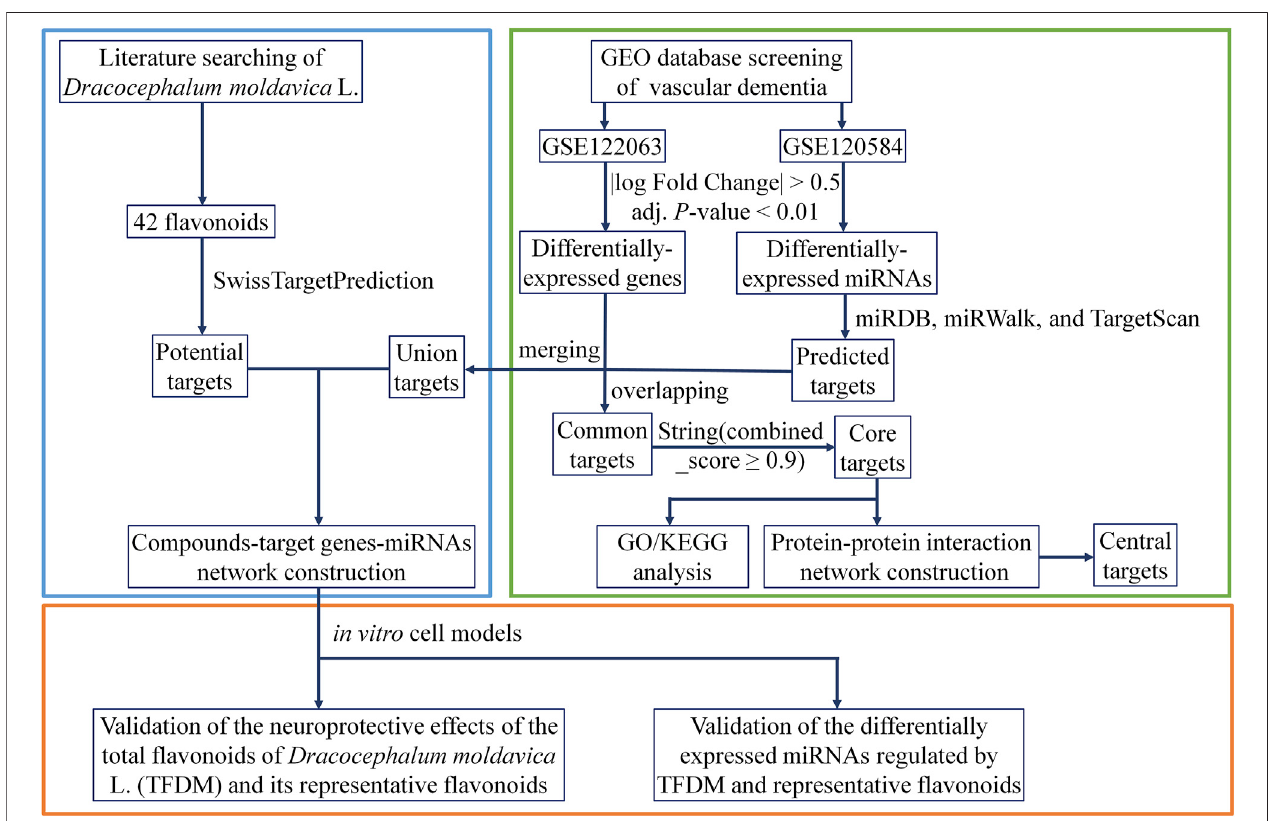
FIGURE 1 | Work fl ow of the present